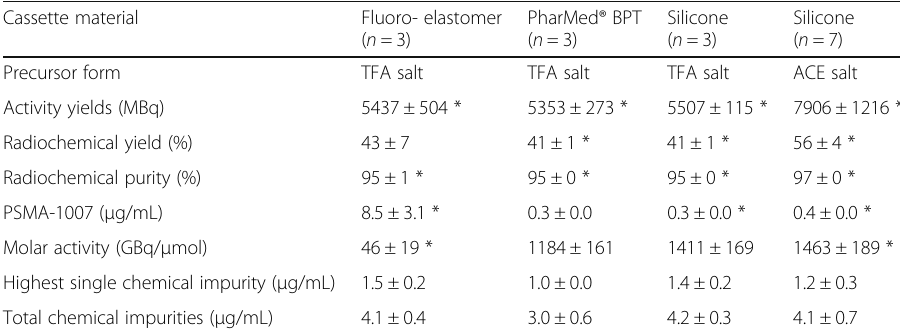
Table 1 Comparison of the three types of cassettes Cassette material